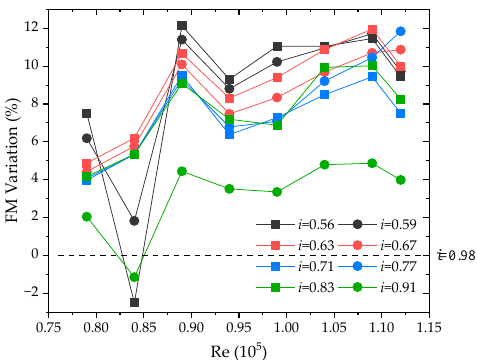
Figure 7. FM variation in hover (compared with i = 0.98).